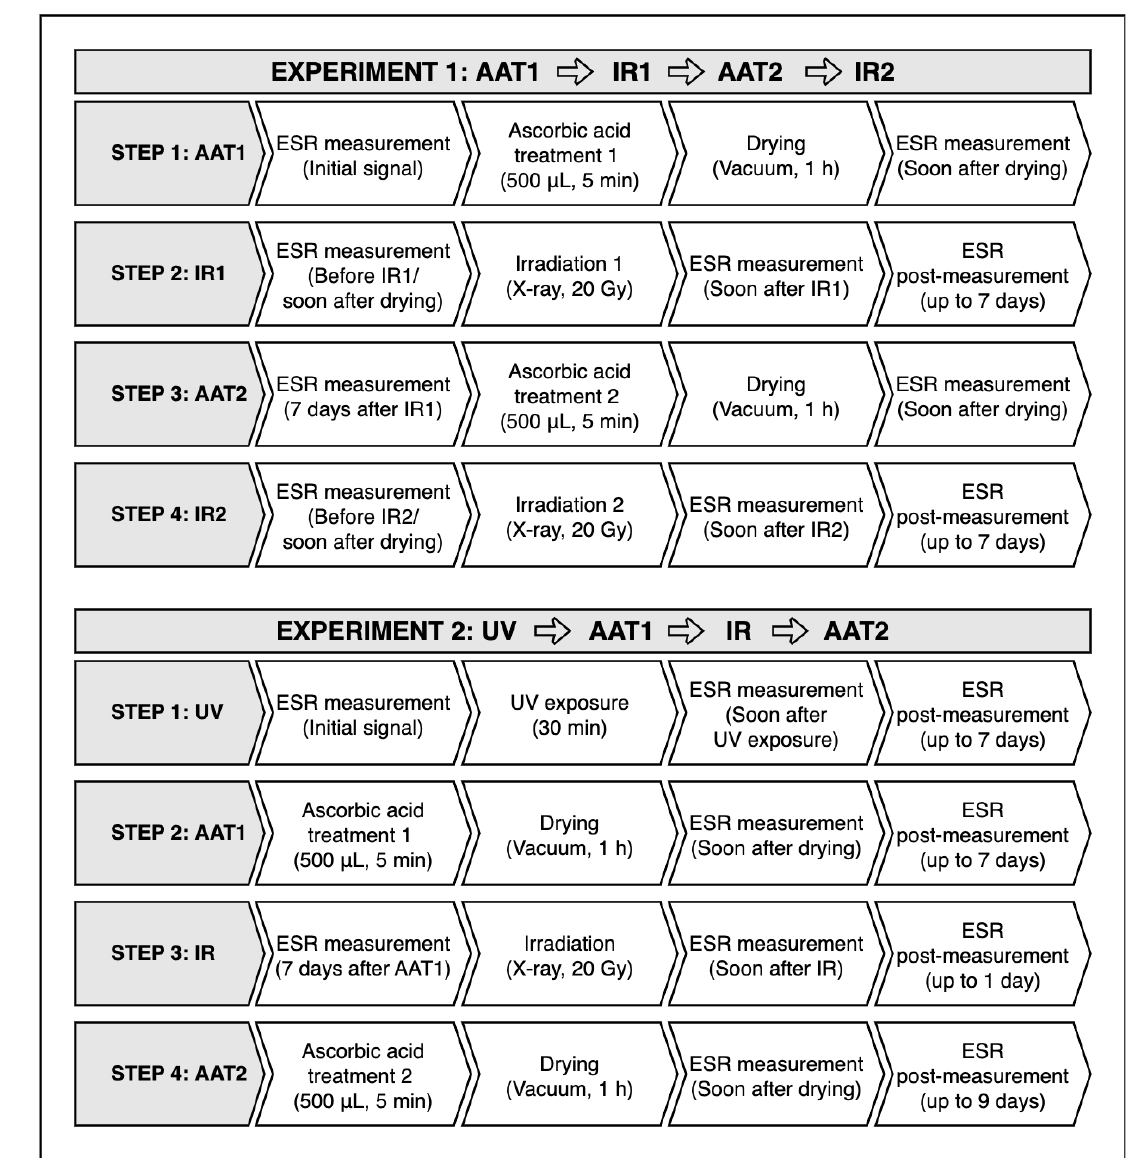
Figure 3. Schematic of the irradiation setup for the fingernail samples exposed to 20 Gy of X-rays.